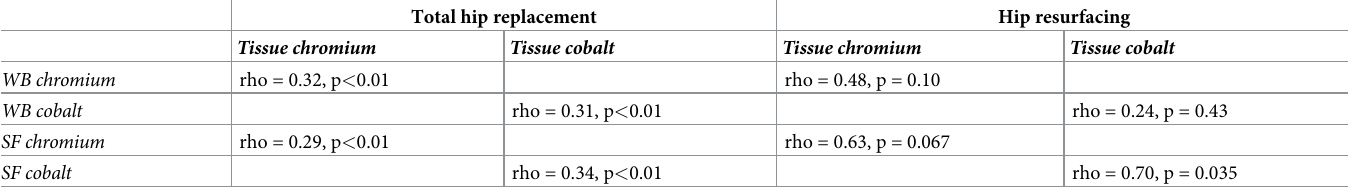
Table 8. Spearman rho correlation coefficients between tissue metal concentrations, whole blood (WB) and synovial fluid (SF) metal ion concentrations in total hip replacement (n = 87) and hip resurfacing (n = 20)